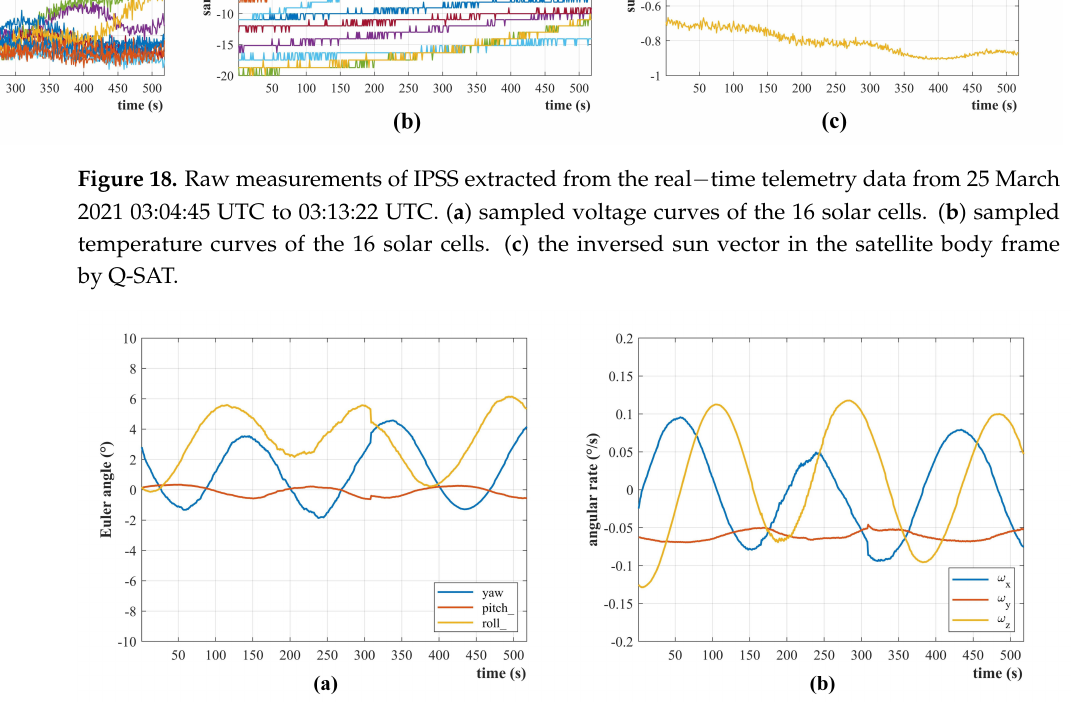
Figure 19. The on − orbit attitude determination results are calculated in real-time by Q-SAT. The data starts from 25 March 2021 03:04:45 UTC to 03:13:22 UTC. ( a ) The attitude is represented by Euler angles (3-2-1) with respect to the orbital coordination frame. ( b ) The angular velocities are defined with respect to the inertial system. The estimated angular velocity in the satellite body Y axis is close to the orbital angular velocity of